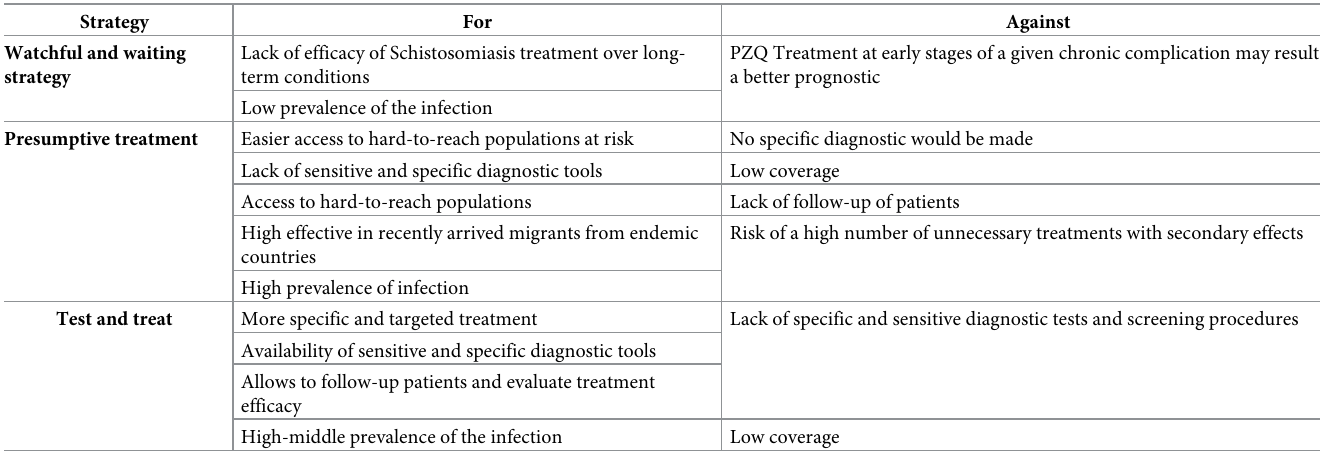
Table 4. For and against each strategy according to different considered